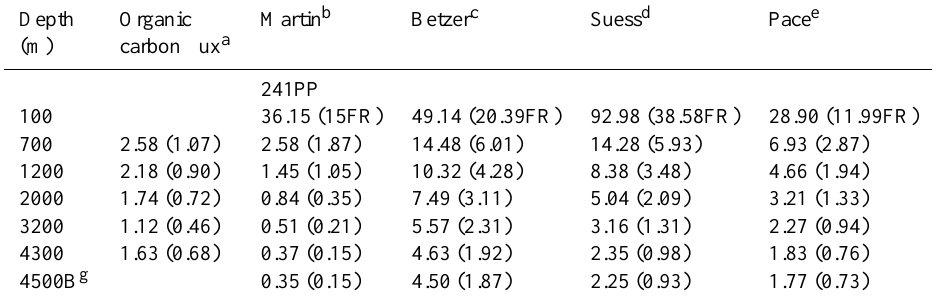
Table 4. Comparison of organic carbon fluxes (in mgCm − 2 d − 1 ) measured by sediment traps and in brackets the corresponding export ratios (%) at various depths with the organic carbon fluxes and export ratios obtained by empirical